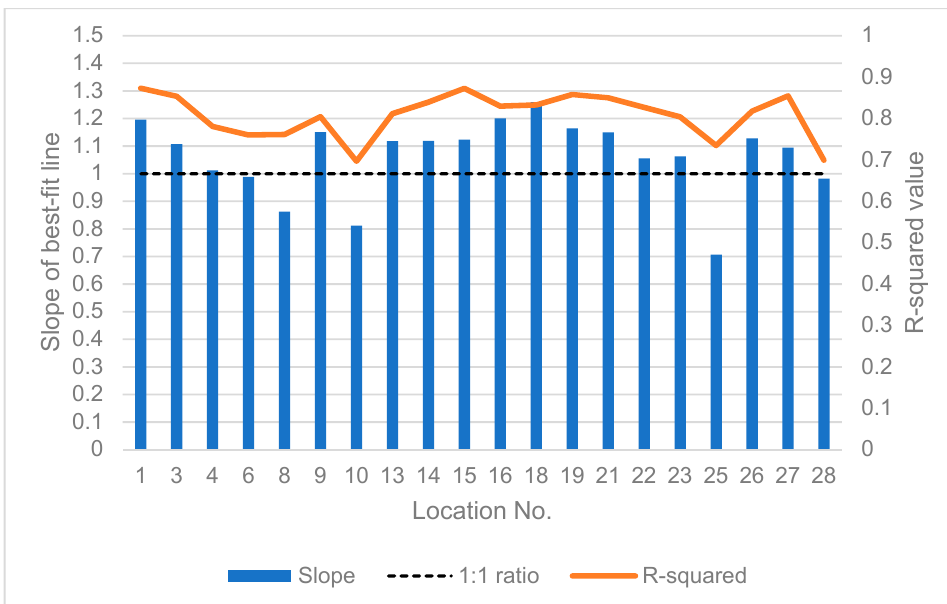
Figure 4. Scatterplot of T air and 2017 Landsat LST image data (for measurement location 1) in Ford Dry Lake.